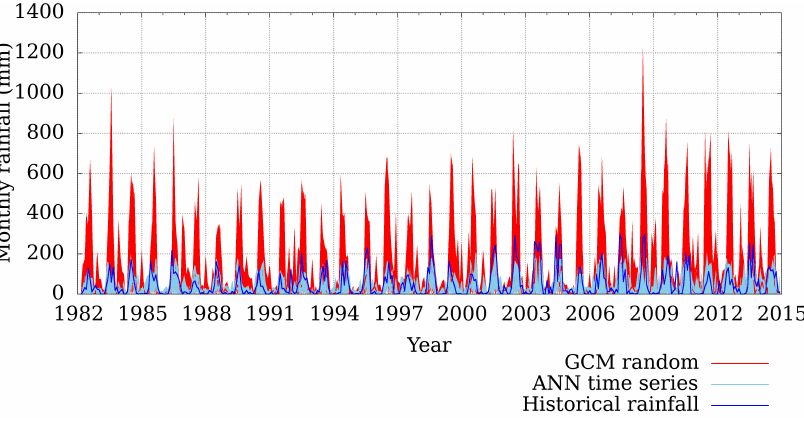
Figure 8. Results of Monte Carlo simulation for random generator 1 (rain gauge: